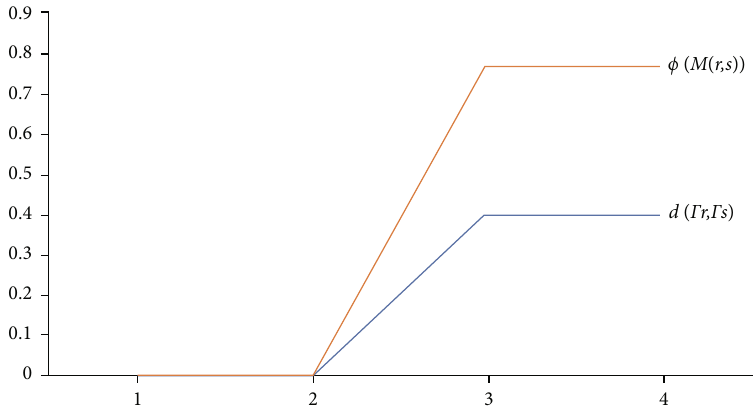
Figure 2: Illustration of contractive inequality (7) for all r , s ∈ f − 1, 1 g